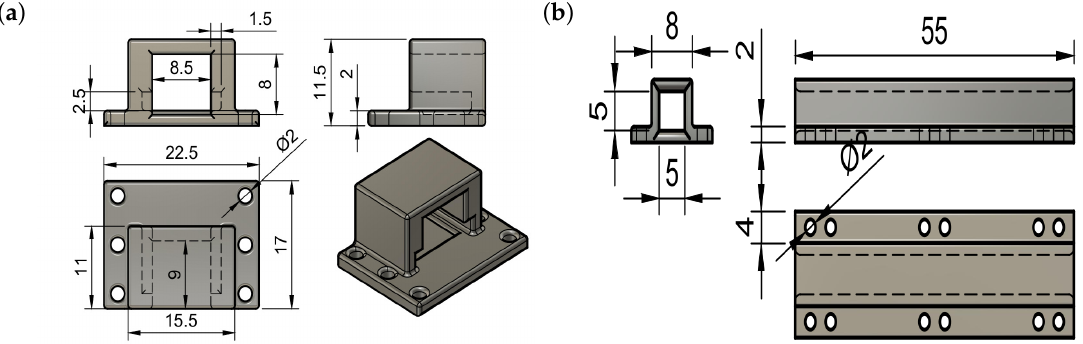
Figure A1. Design of the parts for the sADS sensors. ( a ) Ensures the correct posing on the fixed part. ( b ) Allows correct sliding on the movable part, not only eliminating the problem of skin stretching but also creating a straight line formed by the